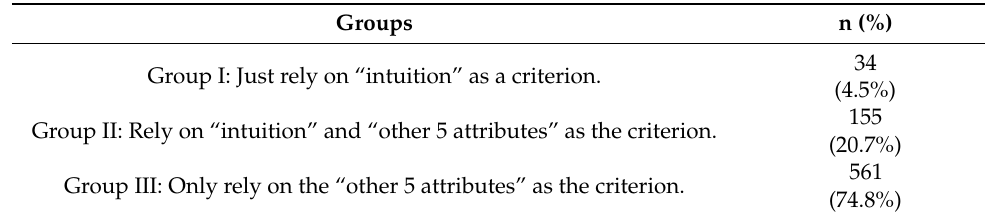
Table 3. Division of the audience into three groups, based on different criteria.